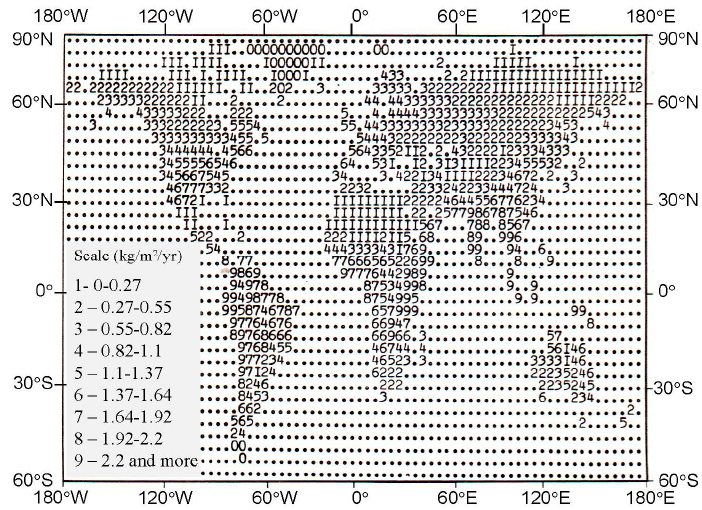
Figure 8. A map-scheme of the productivity of soil-plant formations shown in Table 2 in digital scale with spatial resolution 4° × 5°. Table 5. The dependence of the annual vegetation production R Φ ( T Ξ , W Ξ ) (kg/m 2 /year) on the average annual temperature ( T Ξ ) and full precipitation ( W Ξ ). Precipitation, W Ξ (mm/Year)